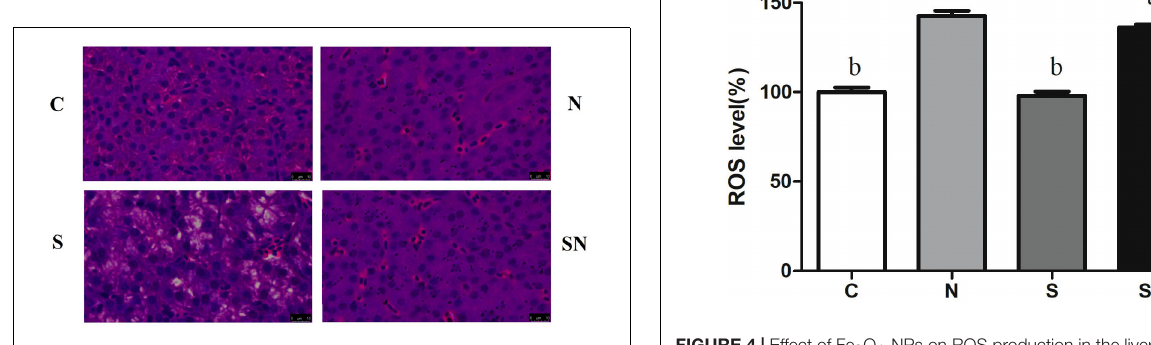
FIGURE 3 | Representative photomicrographs of liver histological section of chickens exposed to Fe 3 O 4 -NPs in the absence or presence of S . Enteritidis administration (scale bar = 10 µ m).